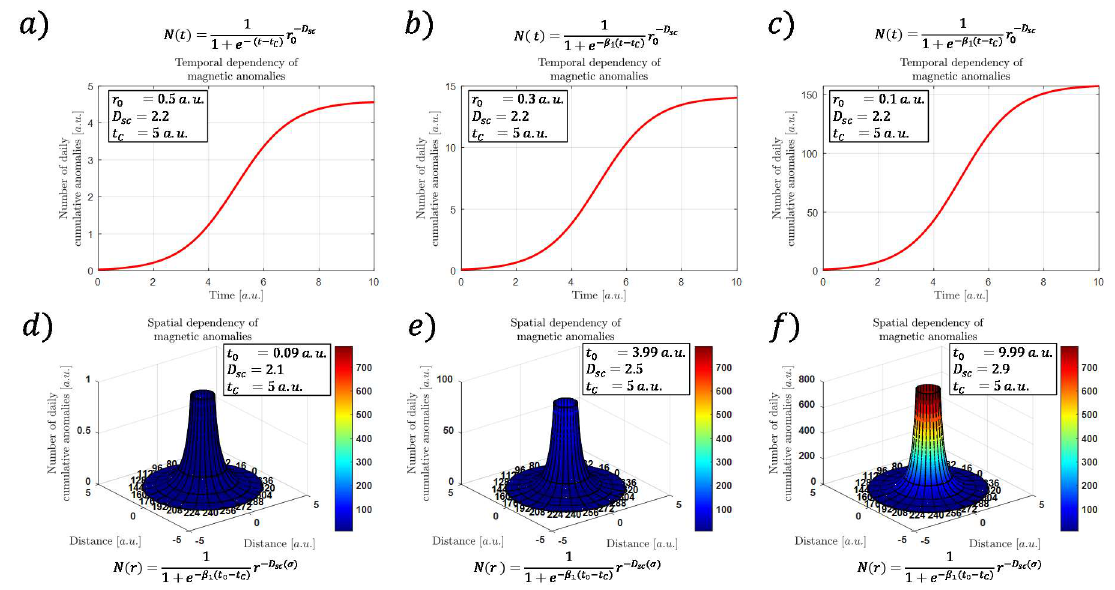
Figure 2. Representation of the number of daily cumulative magnetic anomalies evolution regarding time and position described by Equation (5). ( a – c ) represent the time evolution of Equation (5). Note that the maximum number of anomalies increases while the position r is close to the center. The spatial evolution of the anomalies is shown in ( d – f ). Here, the maximum number of anomalies increases within the spatial domain at different times. Then, magnetic anomalies occur close the center of the preparation zone and increases with time. This implies that Equation (5) effectively shows the clustering of cracks and anomalies.